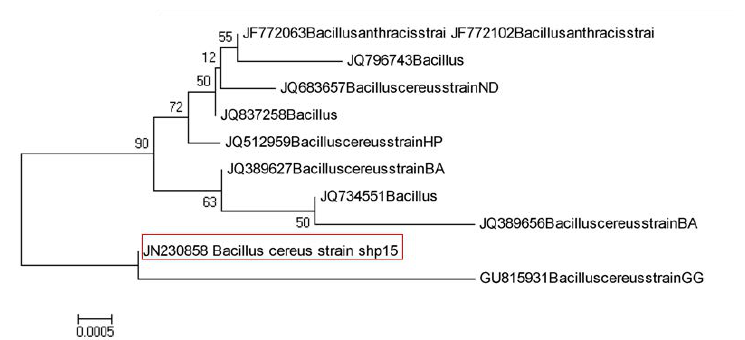
inoculated with Stenotrophomonas maltophilia (RAL-4) showed variations in saturated fatty acids, monounsaturated fatty acids, polyunsaturated fatty acids and trans fatty acids. Increase in short chain as well as middle length chain saturated fatty acids was observed which are responsible for development of rancid, soapy, unclean or bitter flavors. According to Chen et al., (2003) and Huis Veld J (1996), the hydrolysis of as little as 1% of milk triglycerides could lead to rancid off flavors. Jaeger et al., (1994) reported that increased levels of short chain fatty acids (C4 - C8) give rise mainly